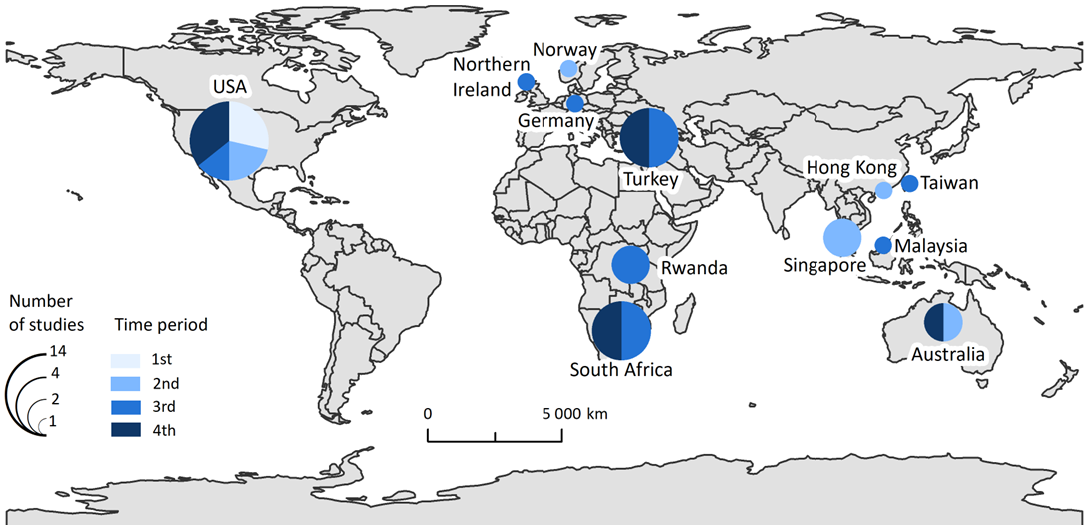
Figure 4. Spatial distribution of the identified studies.